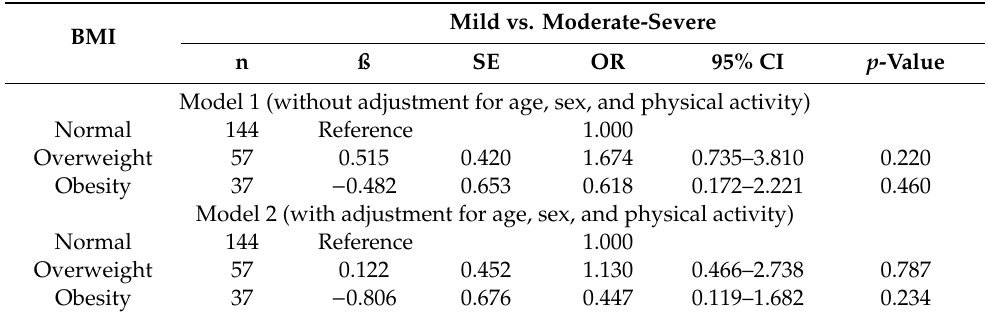
Table 4. Disability status in relation to World Health Organization’s standard of obesity assessed by multivariable logistic regression analysis.